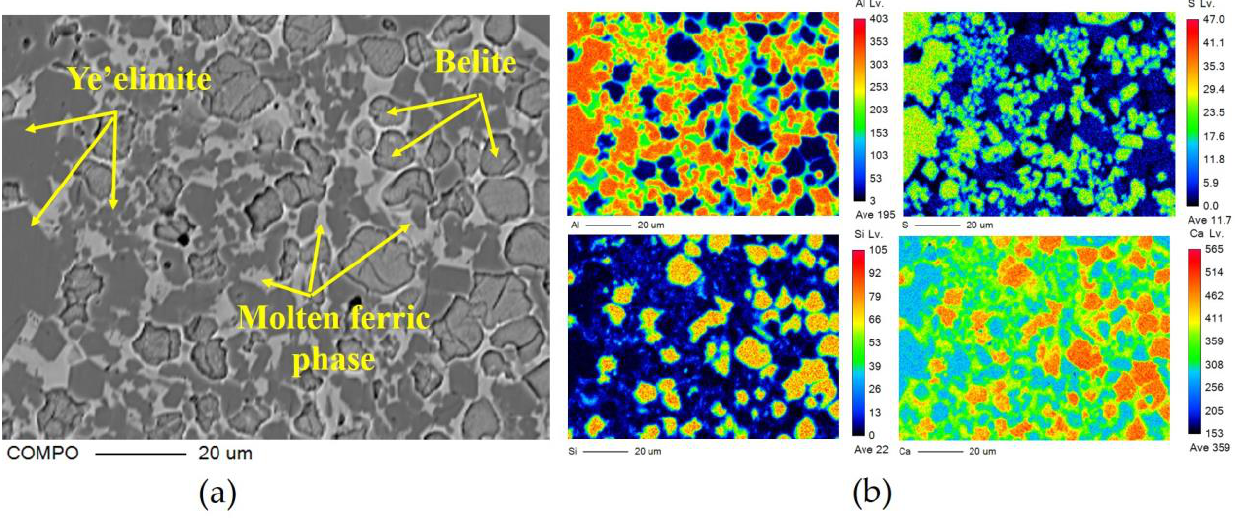
Figure 6. EPMA results of clinker S00: ( a ) BSE micrograph of polished section; ( b ) distribution of all measured elements (Al, S, Si and Ca).